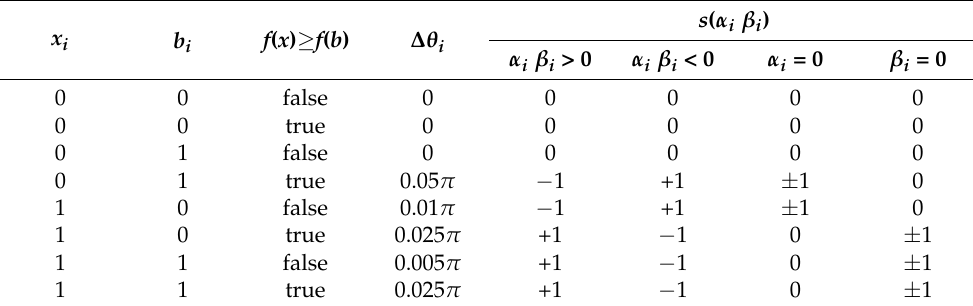
where f (.) is the profit; s ( α i β i ) is the direction sign of rotation angle; and x i and b i are the i th bits of the binary solution x and the best solution b, respectively.